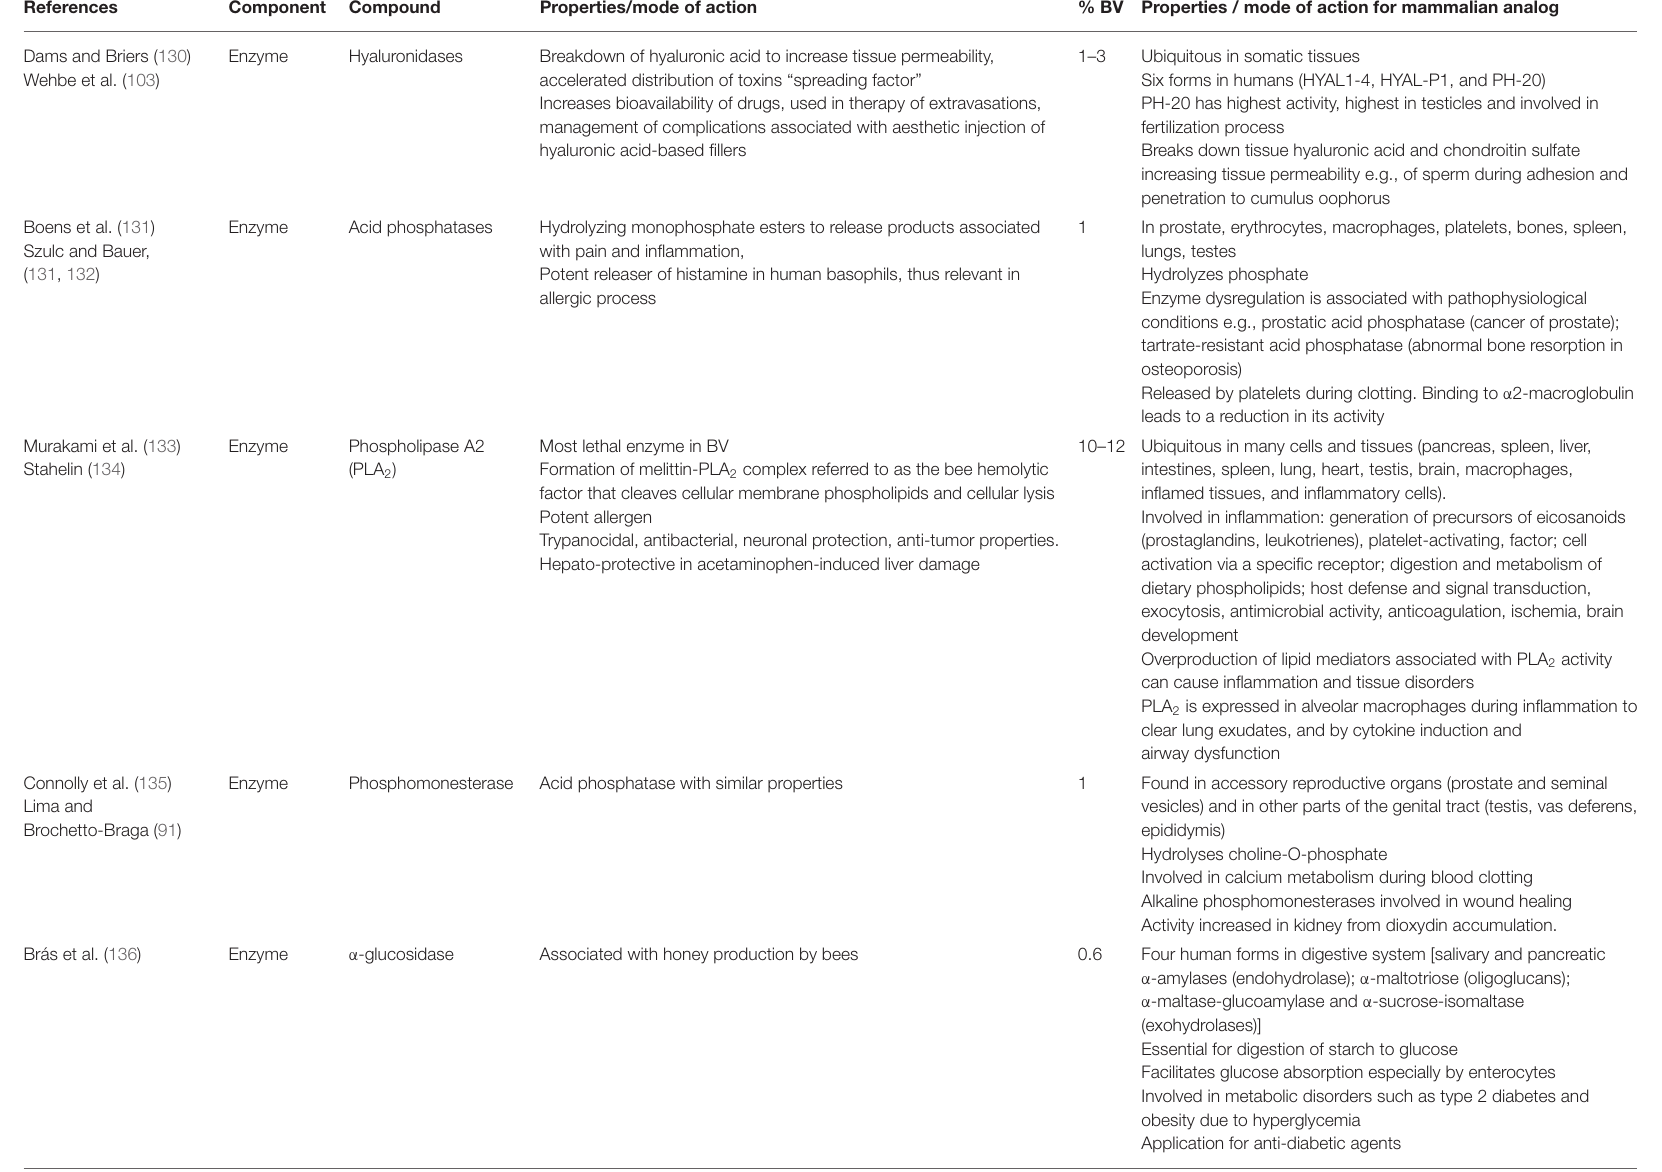
TABLE 1 | Bee venom enzymes and peptides and their functions in mammalian